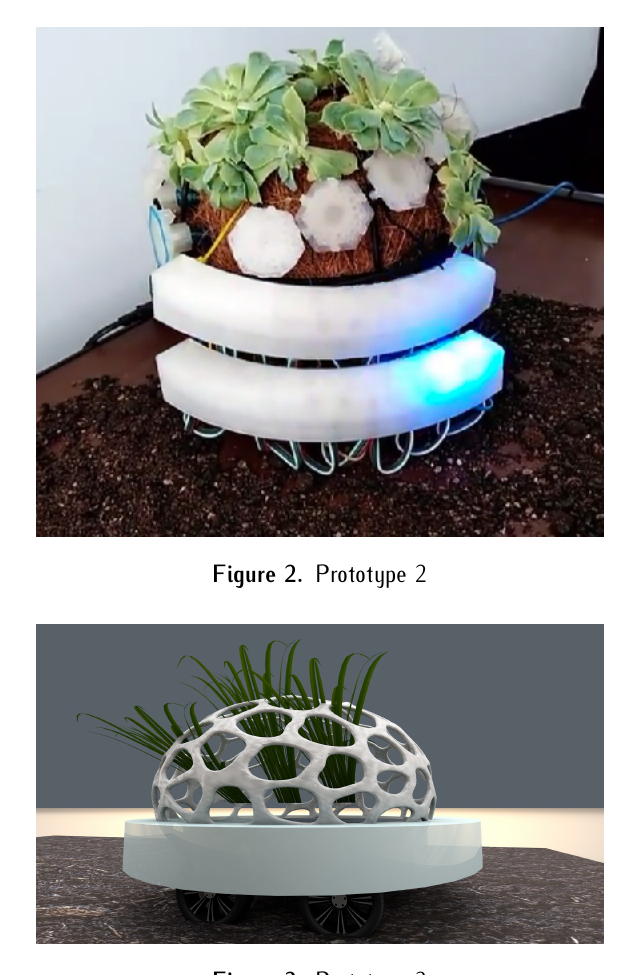
Figure 3. Prototype 3